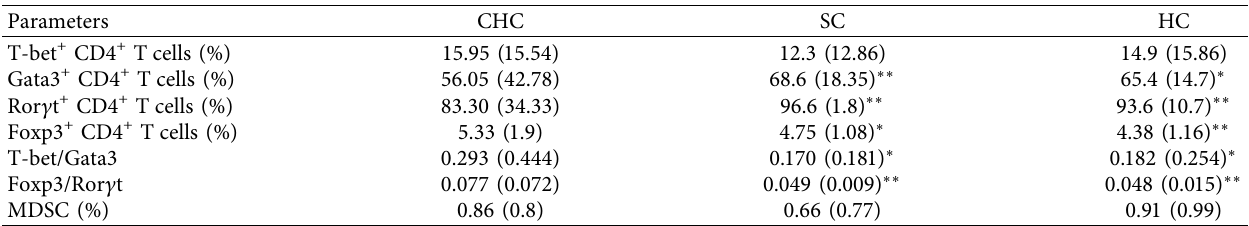
Table 2: Comparison of the expression levels of transcriptional factors and the percentage of myeloid-derived suppressor cells among the study groups.